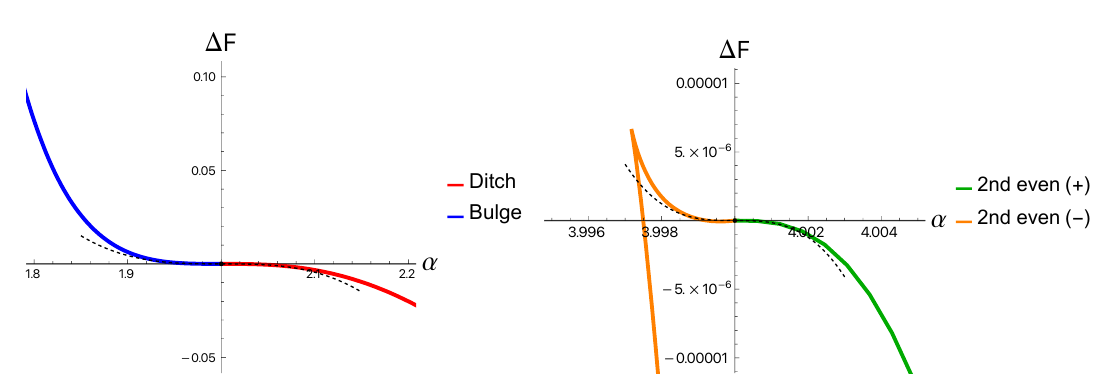
Figure 3 . The comparison with the perturbative result (dashed curves) near the branching points of the first and second even modes. The second branch admits a tiny cups in the (-) side.